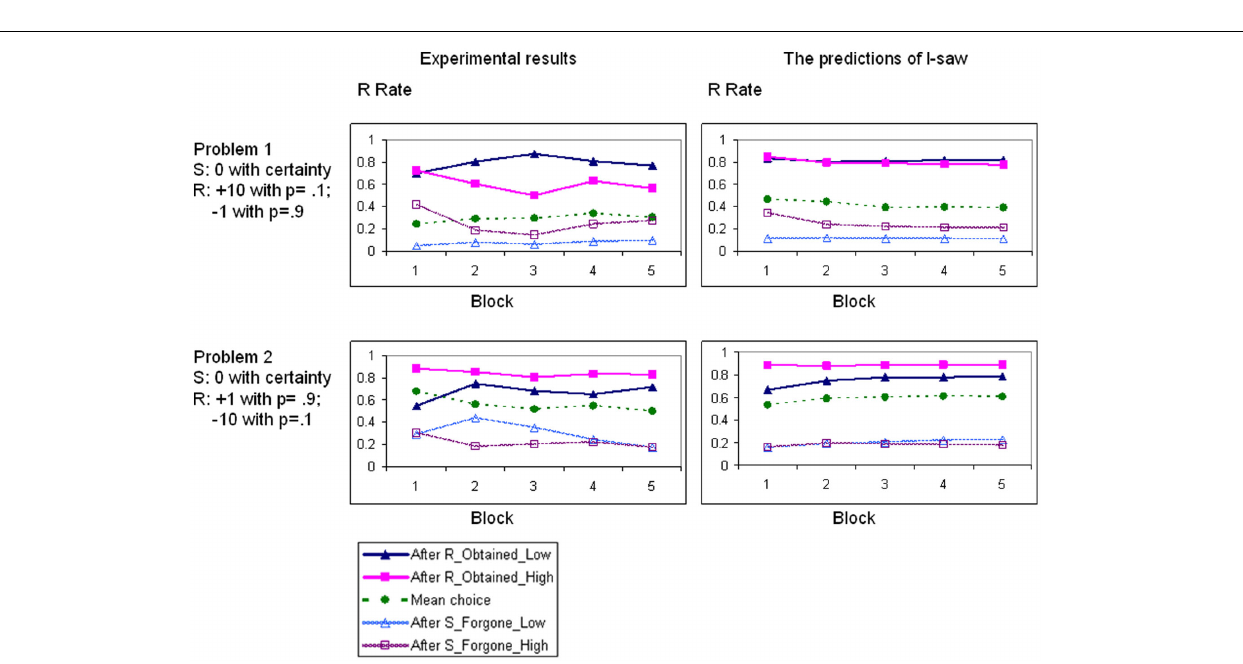
shows the aggregate R -rate (the mean choice rate of the risky option).The other four curves show the R -rate as a function of the choice and the outcome in the previous